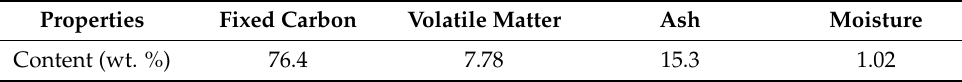
Table 3. The composition of